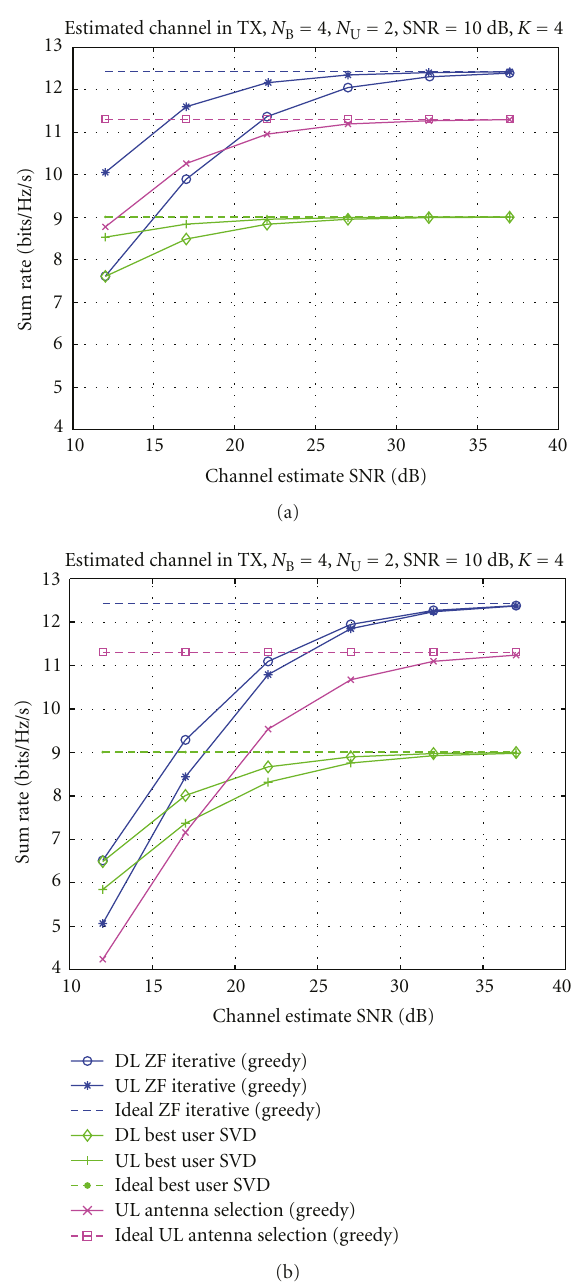
Figure 8: Average sum rate, with noisy CSI and ZF receivers, N B = 4, N U = 2, K = 4, D S = 0: (a) estimated CSIT and ideal CSIR, (b) estimated CSIT and estimated CSIR.